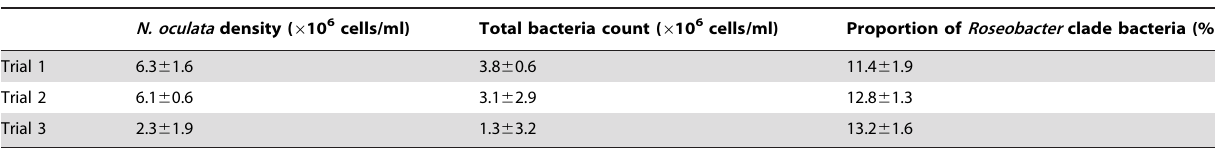
Table 1. Estimation of Roseobacter clade populations in N. oculata